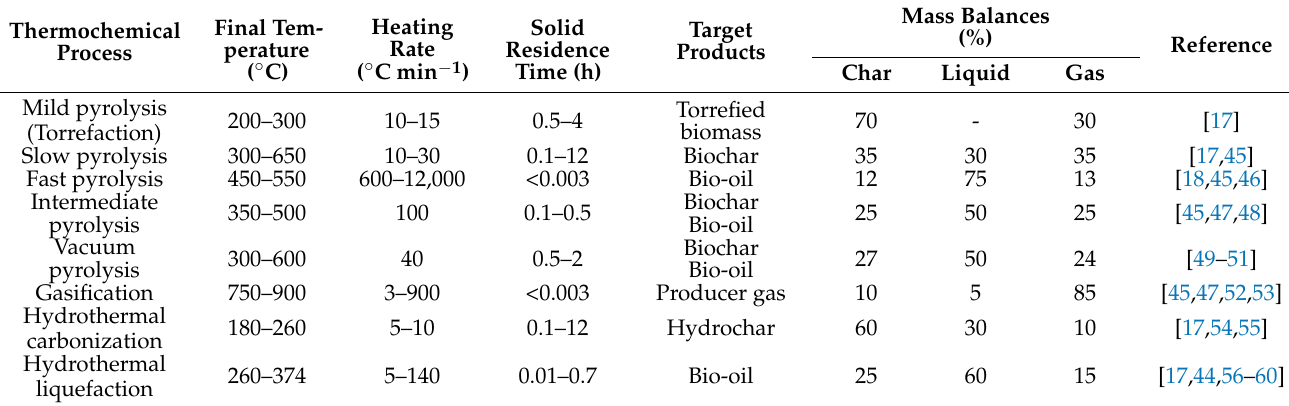
Table 1. Main thermochemical